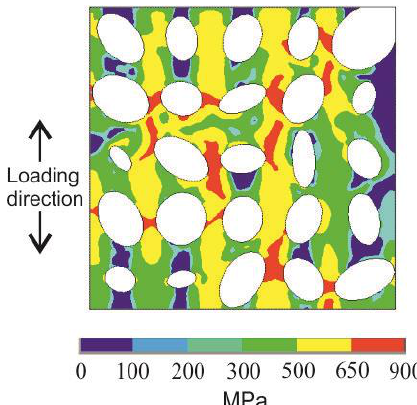
Figure 4. Example of Von Mises stress distribution at macroscopic yield. The case studied corresponding to a porous compact fabricated by a 40 vol.% NH 4 HCO 3 space